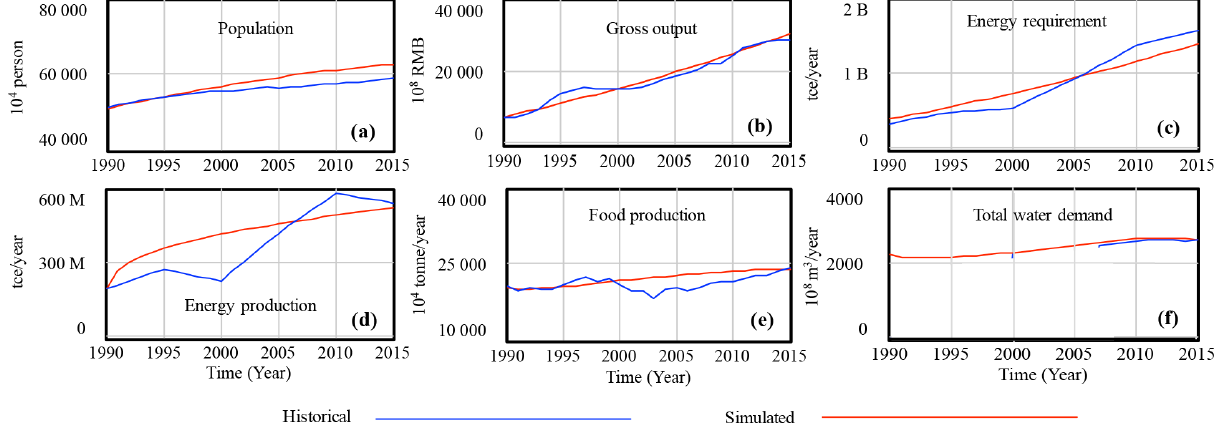
Figure 17. Comparison of simulated and historical system behavior. Table 4. Parameters used for sensitivity tests of main state